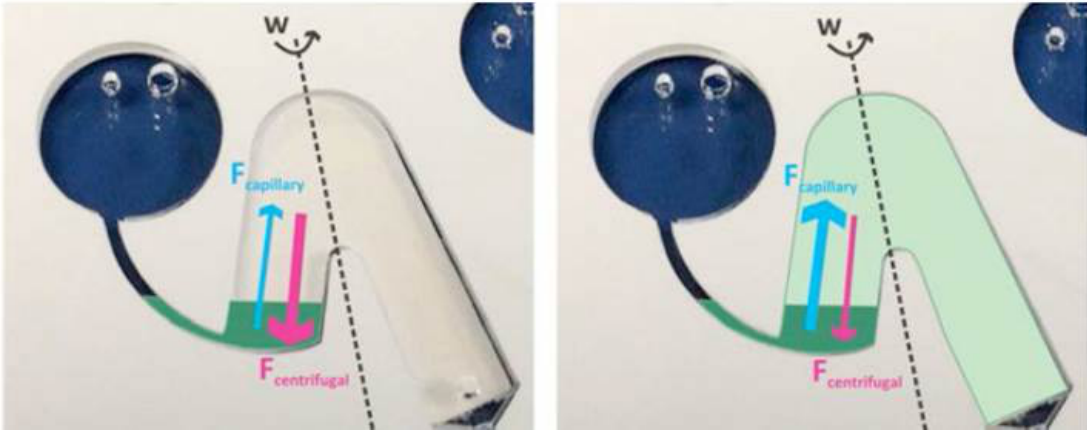
Figure 6. Example of hybrid paper-on-a-disc device using a paper siphon in a chamber on a microfluidic disc. Opposing effects of centrifugal and capillary forces are shown for F centrifugal > F capillary ( left ) and F capillary > F centrifugal , where liquid is absorbed by the paper ( right ). Reproduced from [81] with permission from the Chemical and Biological Microsystems Society,